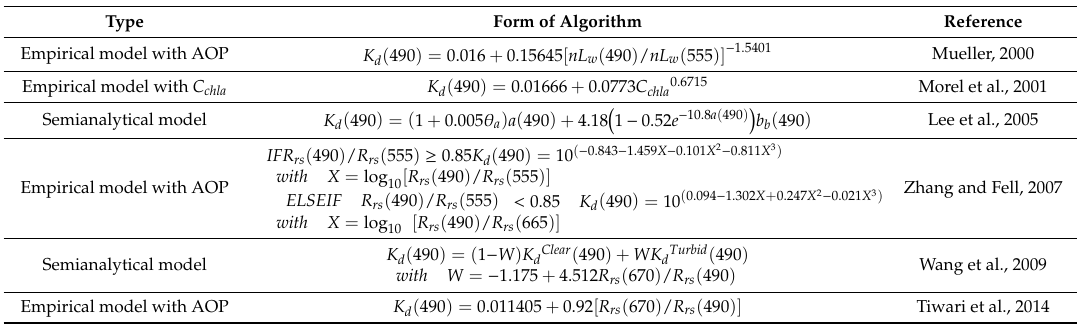
Table 2. Description of di ff erent algorithms for K d (490) retrieval, where nL w denotes normalized water-leaving radiance, θ a denotes above surface solar zenith angle, a denotes absorption coe ffi cient, b b denotes backscattering coe ffi cient, K dclear (490) denotes the model for open clear water, and K dturbid (490) denotes the model for coastal turbid water (AOP refers to apparent optical